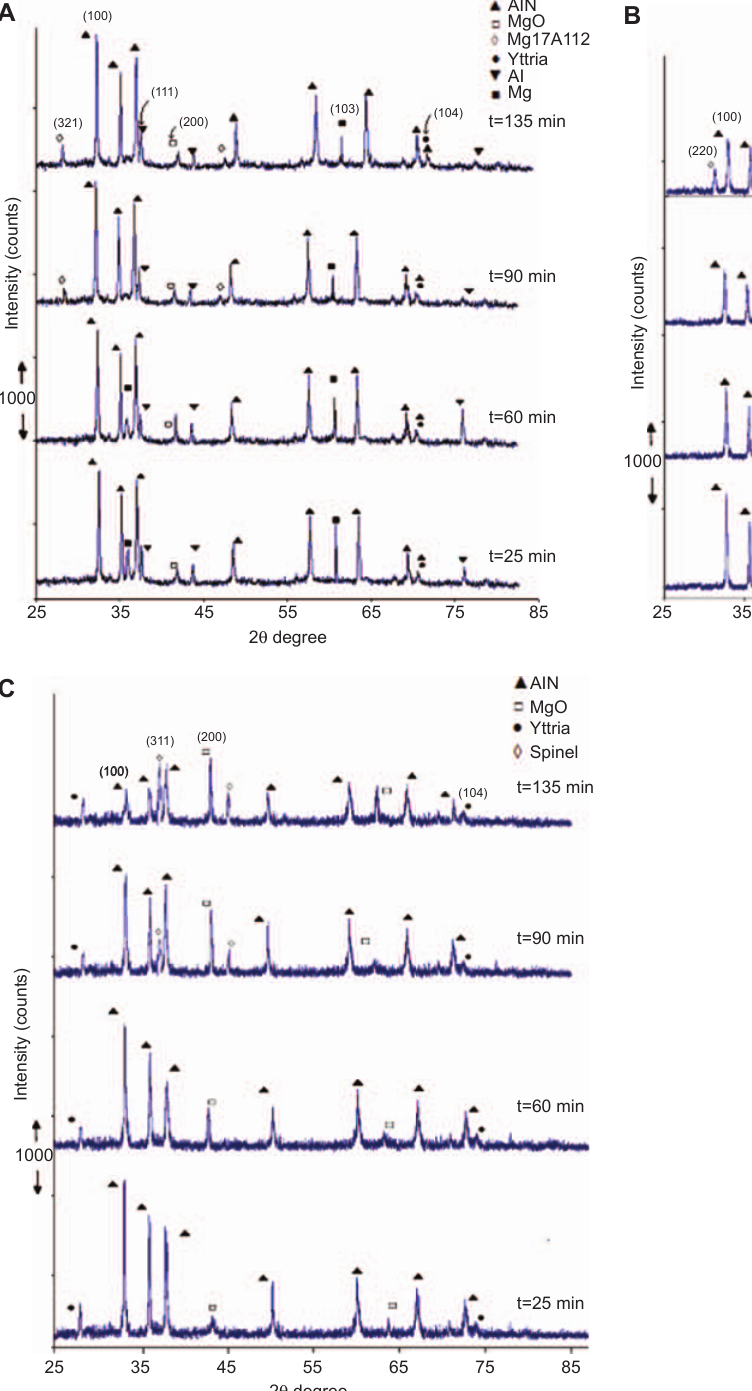
Figure 4 XRD patterns for infi ltration at (A) 650 ° C, (B) 800 ° C, and (C) 950 ° C for different holding